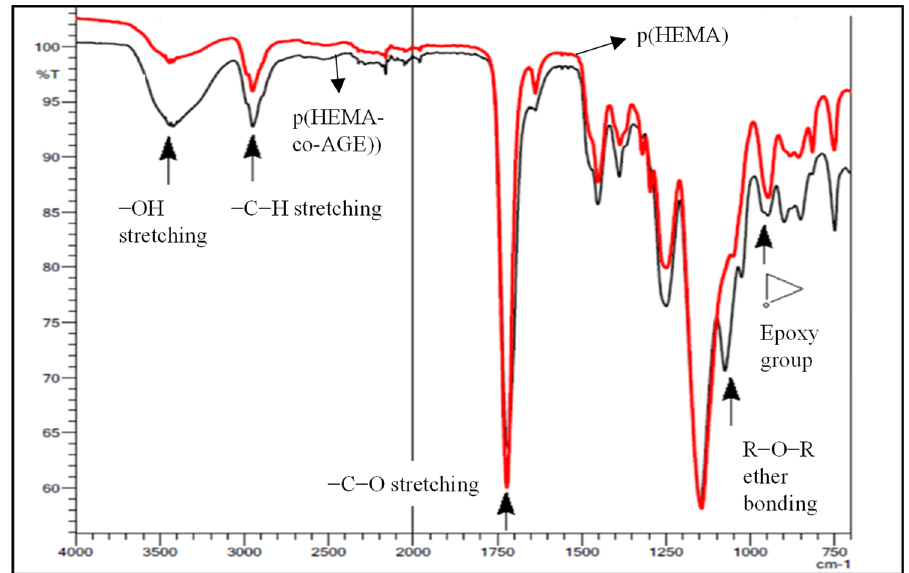
Figure 2. FTIR − ATR spectra of p(HEMA) and p(HEMA-co-AGE) cryogels.